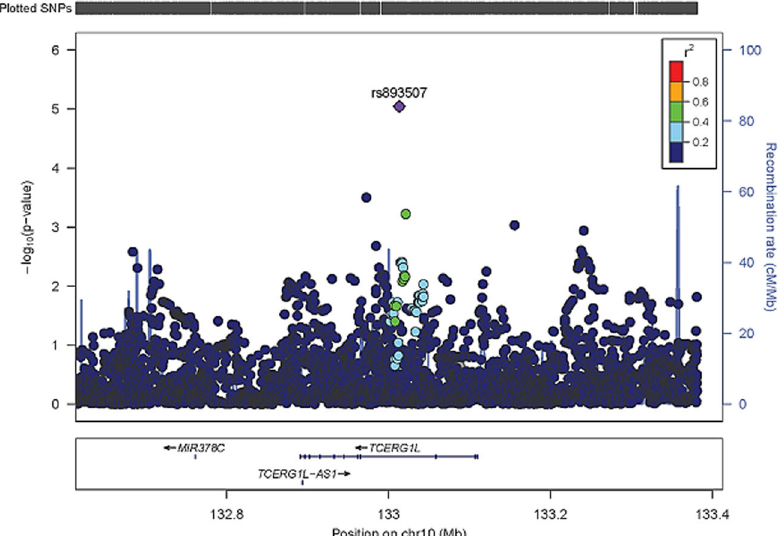
Fig. 1 GWAS analysis uncovers variation at the TCERG1L locus that is associated with cisplatin-induced hearing loss. The purple diamond (genotyped SNP) is the SNP with the lowest p -value ( P < 1.0 × 10 − 5 ) in the region. The color of the remaining SNPs represents the LD of these variants (genotyped or imputed) with the top variant. The blue lines represent recombination rates in this locus.